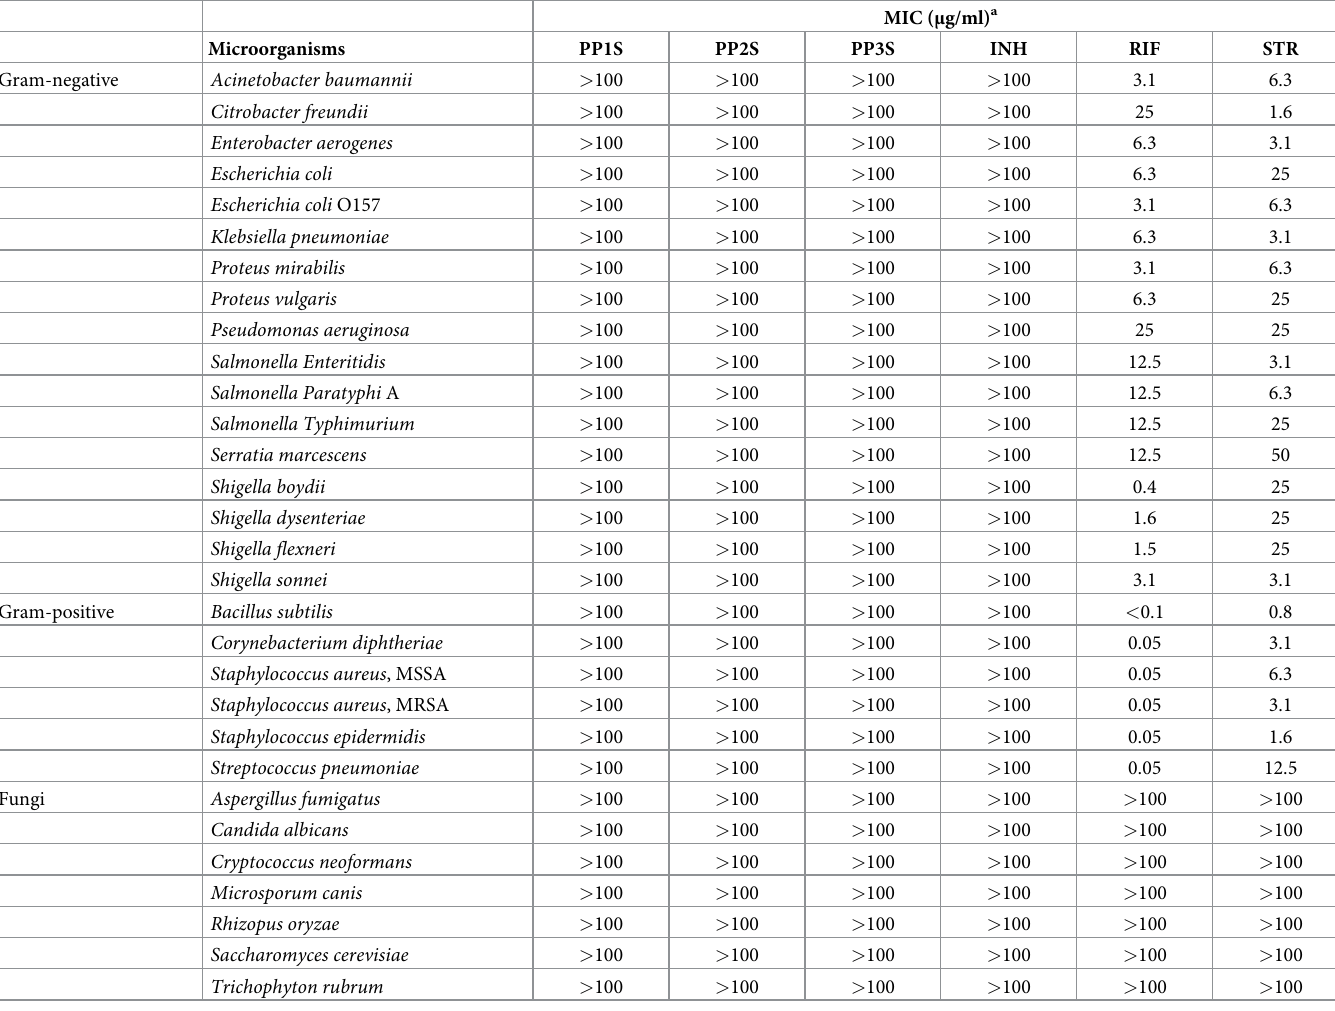
Table 4. MIC values of PPs and control drugs against 23 gram-positive/gram-negative bacteria and 7 fungal